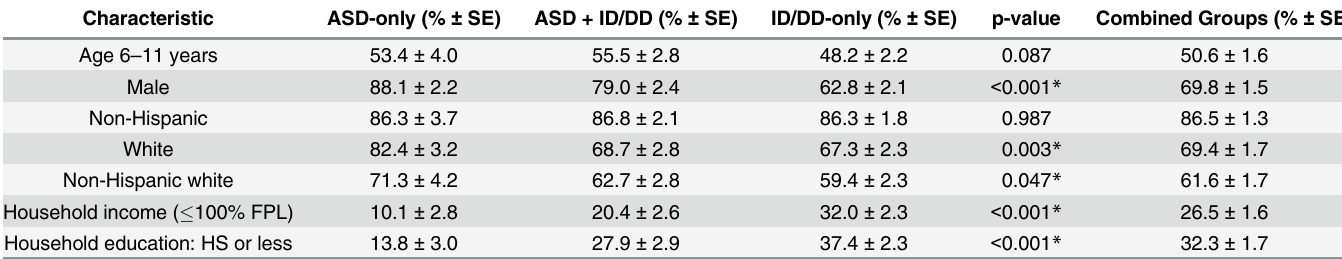
Table 1. Demographic Differences among Condition